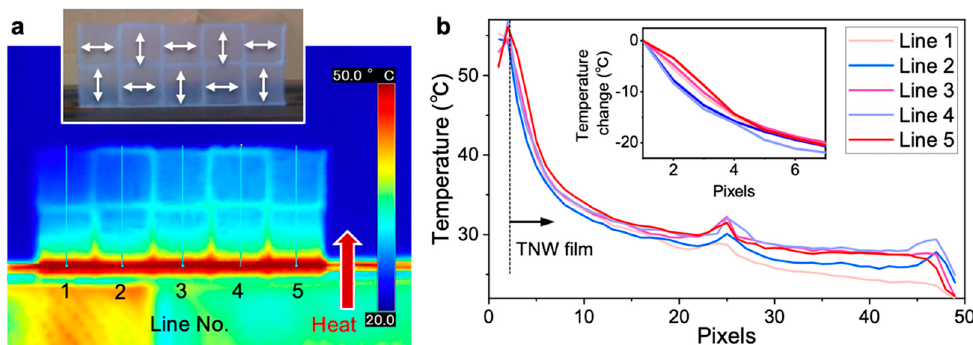
Figure 5. Thermal transport properties of the checkered film of TNWs. ( a ) Thermograph of the film cantilevered by a hot-press machine at 60 °C. The insert shows a photograph of the cantilevered film with the patterning directions indicated by double-headed arrows. ( b ) Temperature profile on each line defined in (a) from the hot-press machine at the pixel of line 1. The insert shows the relative temperature change in each line from the holding end of the film.